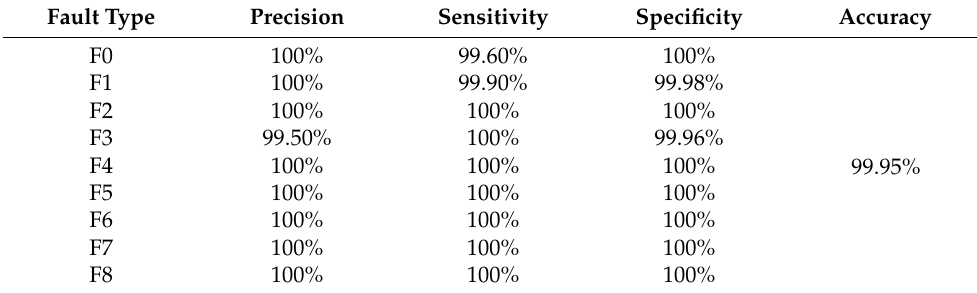
Figure 10. The confusion matrix of the best and worst prediction testing results based on training on dataset 2A. Table 8. The testing results of the confusion matrix of the best prediction WAR-DIC model trained on dataset